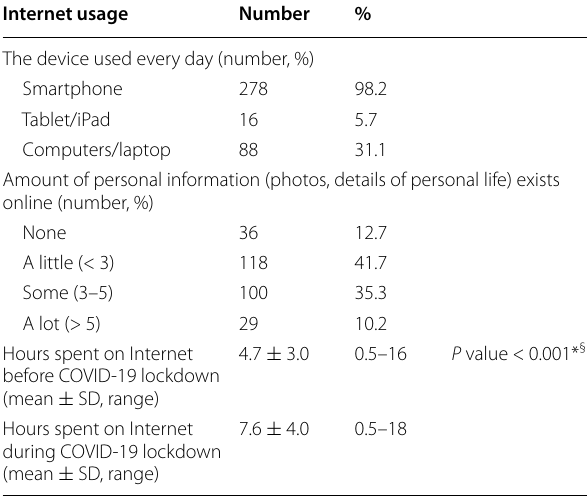
Table 2 Internet usage among the harassed study participants